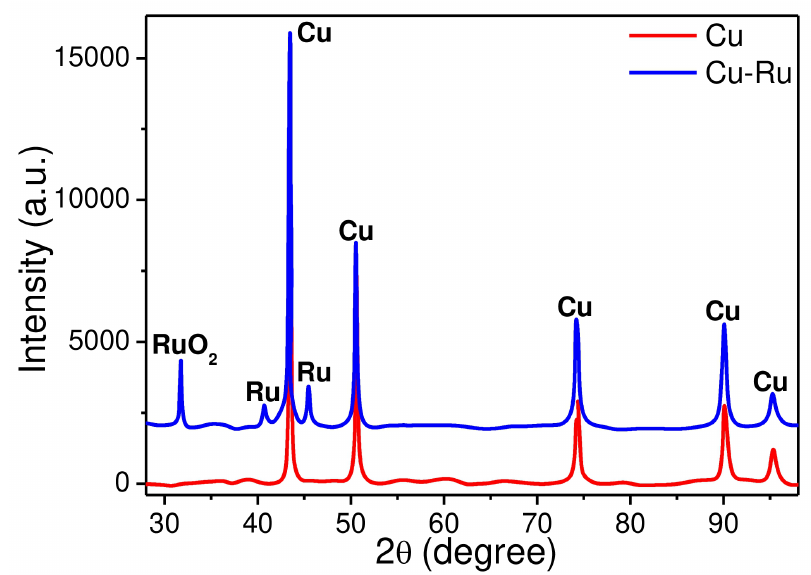
Figure 5. The XRD patterns of Cu and Cu–Ru electrodes fabricated at the optimized physical (laser power, scanning speed) and chemical parameters (composition of